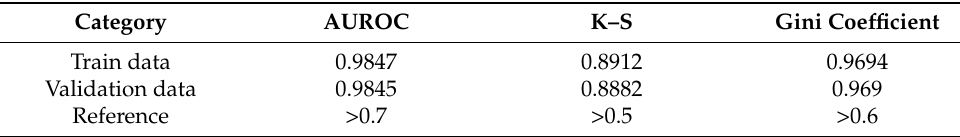
Table 4. Performance metric table for training data and validation data.